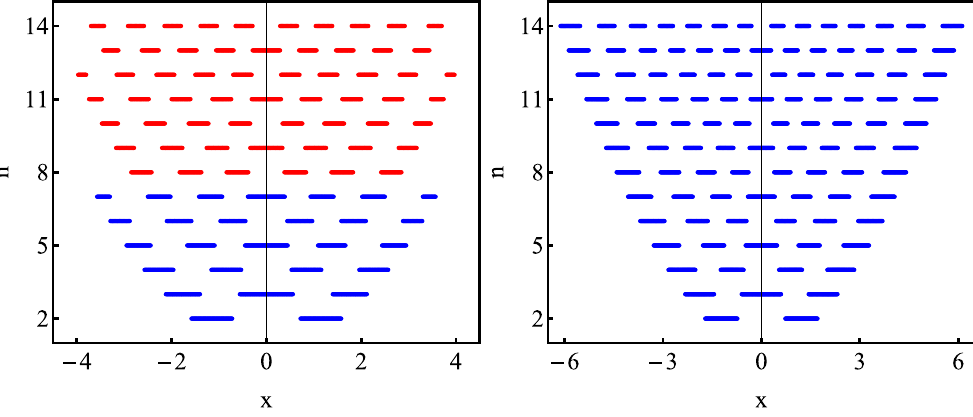
Figure 3. The values of the quadrature x , for which the cut through the output (not normalized) Wigner function W out ( x , 0) exhibits negative values, plotted against the number n of input states of the quantifier. The inputs of the quantifier are copies of the realistic estimated density matrices ρ ˆ both states, M = 2. Blue lines denote the case when the output Wigner function exhibits the Fock state | n 〉 like negativity. Red lines denote the case when the output Wigner function does not exhibit the full Fock state | n 〉 like